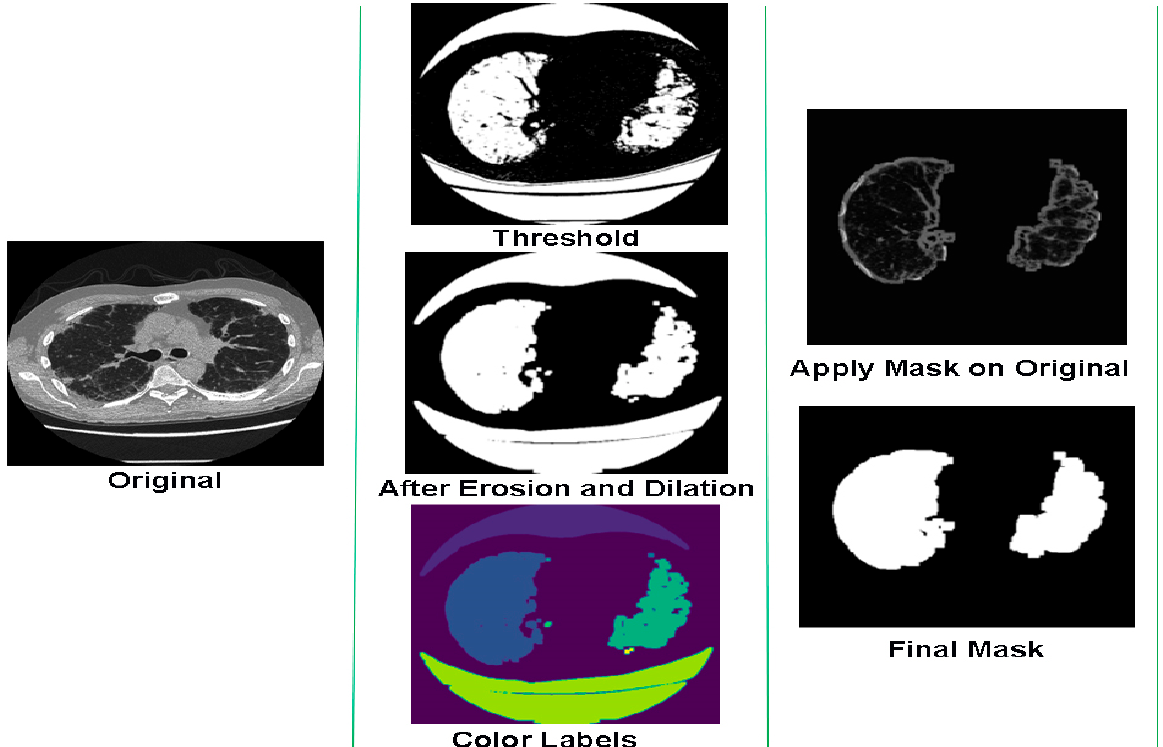
Figure 5. Pictorial representation of the segmentation steps used to generate the final masked chest CT image.